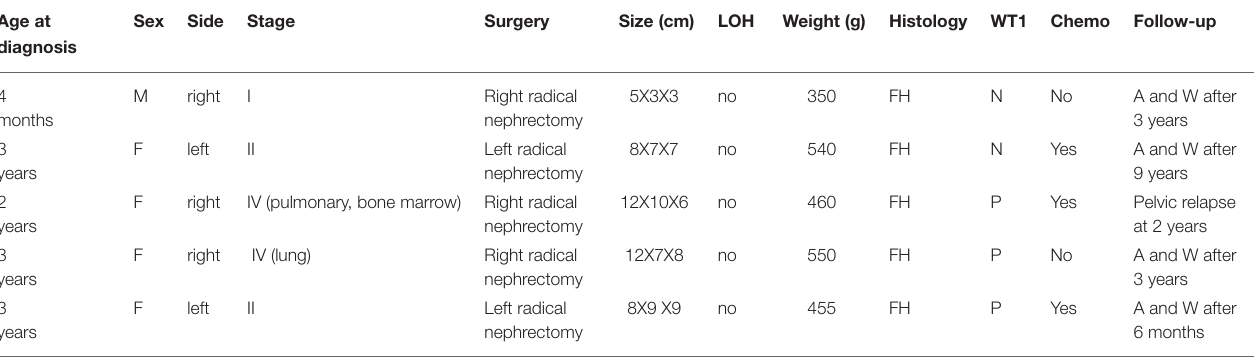
TABLE 1 | Teratoid Wilms tumor patient information in our hospital. Age at